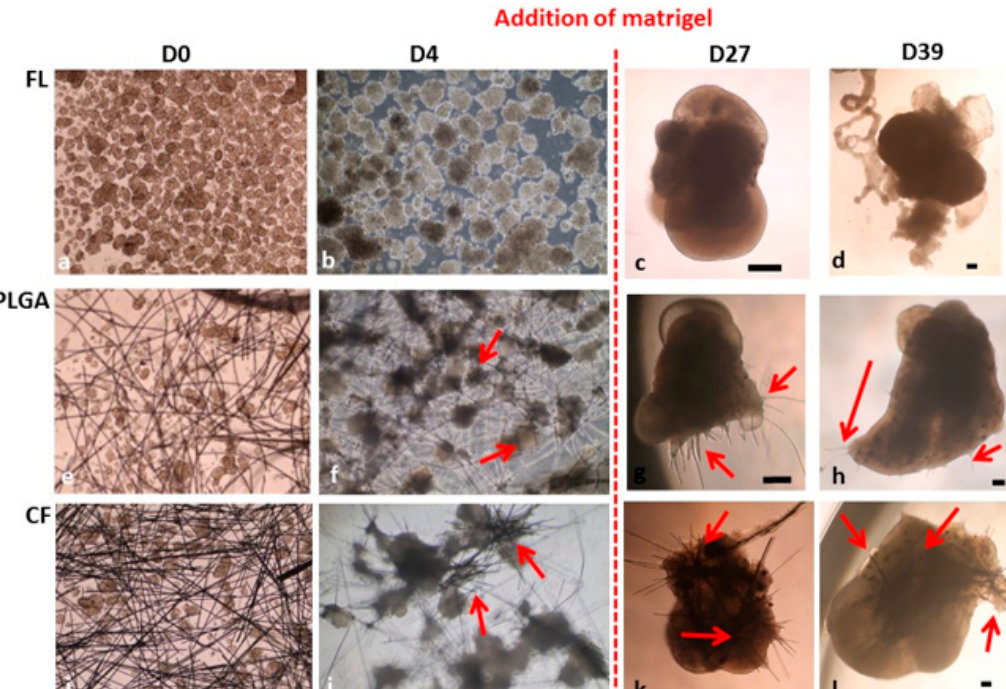
Figure 3. ( A ) Representation of midbrain dopaminergic (mDA)organoid formation, indicating critical steps in the procedure. Organoids were cultured without scaffold (fiber ‐ less, FL) or on scaffolds selected from biocompatible materials (i.e., carbon fibers (CFs) and poly ‐ (lactic ‐ co ‐ glycolic acid) (PLGA) microfilaments). The diagram shows the stages of creating organoids (Figure S1), with particular emphasis on the days when the differentiation media are changed. ( B ) Selected micrographs representing development of organoids starting from freshly detached protein ‐ induced pluripotent stem cell (piPSC) colonies on day 0 (FL), magnification 40× ( a ); with the addition of PLGA scaffold, magnification 40× ( e ); with the addition of CF scaffold, magnification 40× ( i ). On day 4 embryoid bodies (EBs) are formed without scaffold (FL), magnification 100× ( b ); encircling the PLGA scaffold, magnification 100× ( f ); and the CF scaffold, magnification 100× ( j ). Then, a Matrigel marked with a red dotted line was added to these EBs. In the following days, the resulting organoids ( c , d ), PLGA scaffold organoids ( g , h ), and CF scaffold organoids ( k , l ) matured. Scaffolds incorporated into the organoid are marked with red arrows. Scale bar 200 μ m.